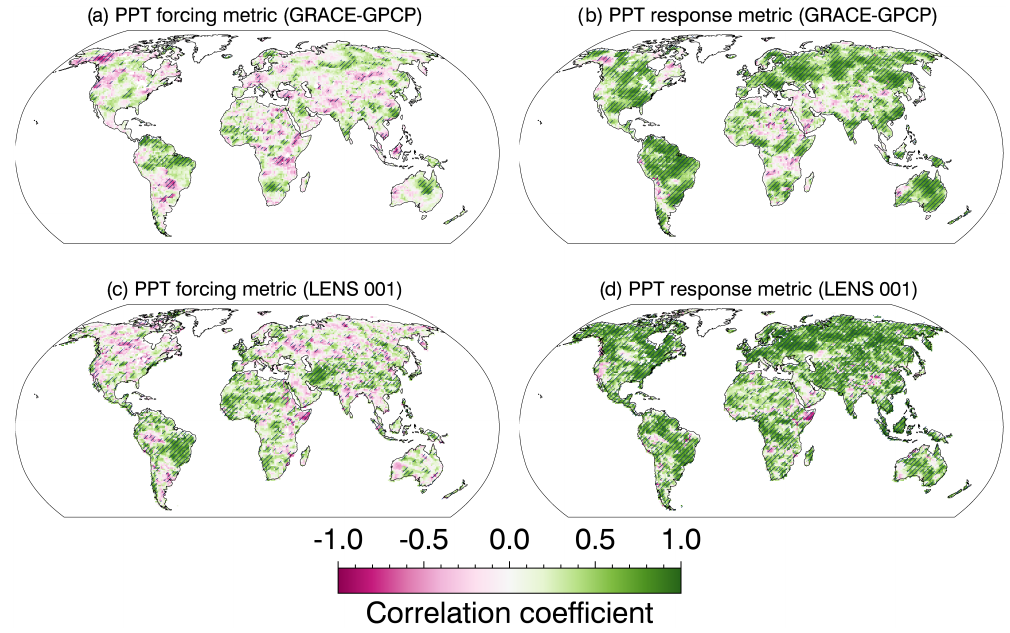
Figure 6. Forcing and response metrics for PPT from GRACE/GPCP (a, b) and LENS ensemble member 001 (c, d) . Cross-hatching indicates a correlation coefficient that is statistically significant at p ≤ 0.05.